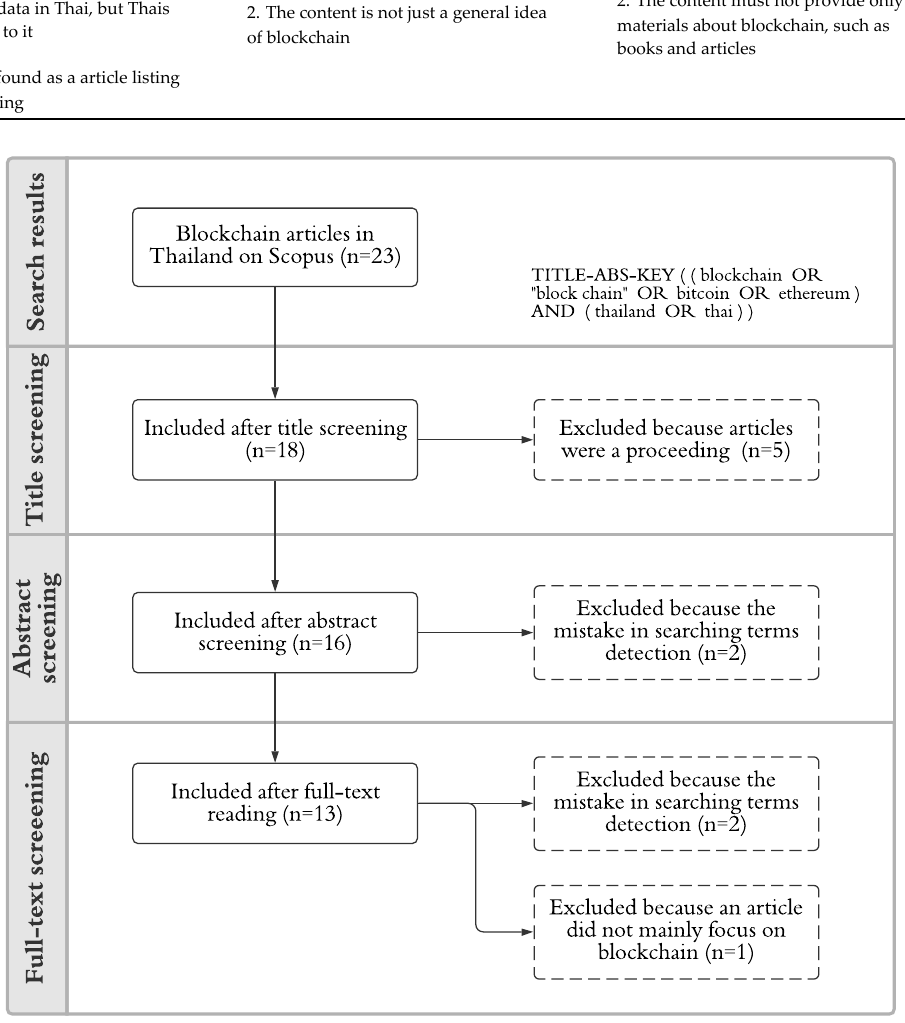
Figure 3. A flowchart of the research articles selection